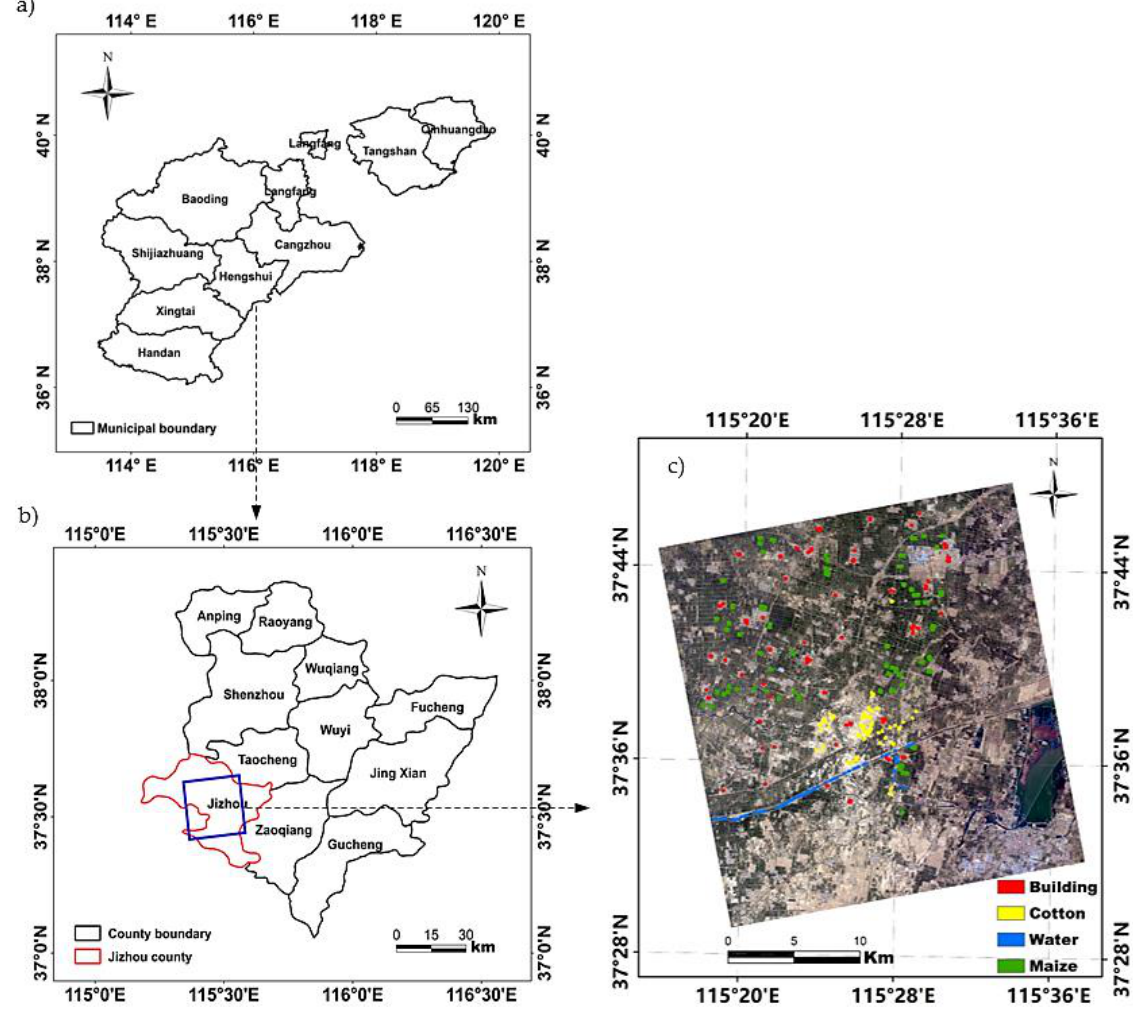
Figure 1. ( a ) Hebei plain, ( b ) location of the study area and ( c ) the distribution of sample plots shown on a GF-1 PMS image.